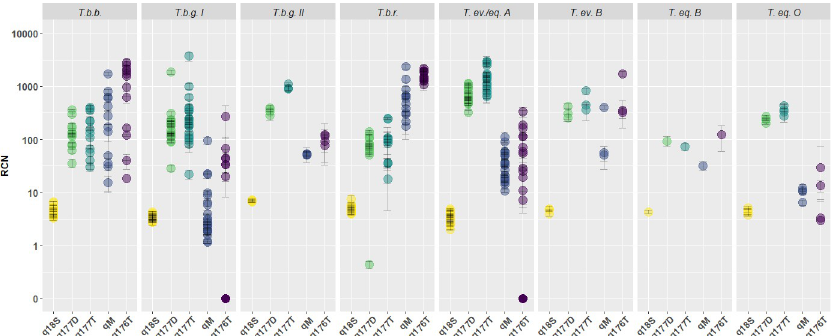
Fig 3. RCNs for 18S rDNA and the TBR repertoire within 77 Trypanozoon strains. All Trypanozoon strains were tested at 50 ng of pure genomic DNA. Mean and standard deviation were calculated using three replicates for each sample. RCNs for 18S rDNA were calculated using the Δ C q -method between q18S and qGPI-PLC. RCNs for the TBR targets q177 D, q177 T, qM and q176 T were calculated using the Δ C q -method with q18S as reference.